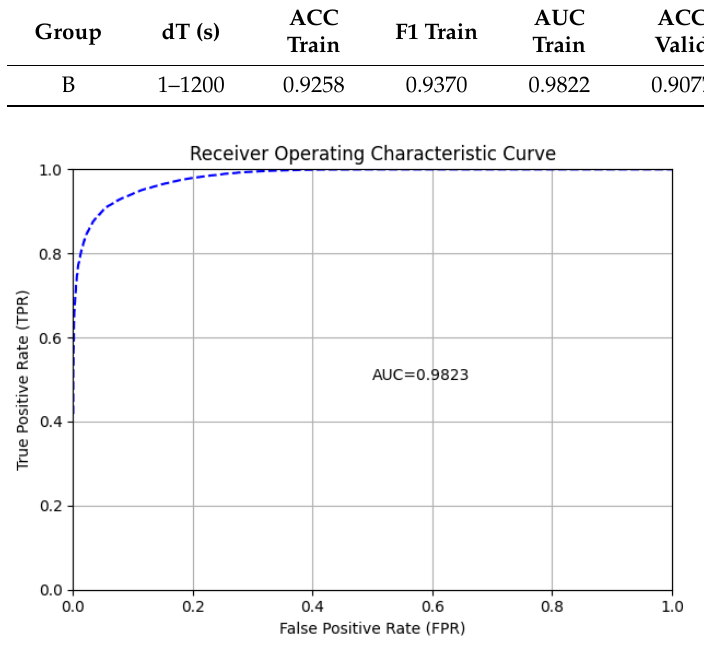
Figure 4. The ROC curve for the results presented in Table